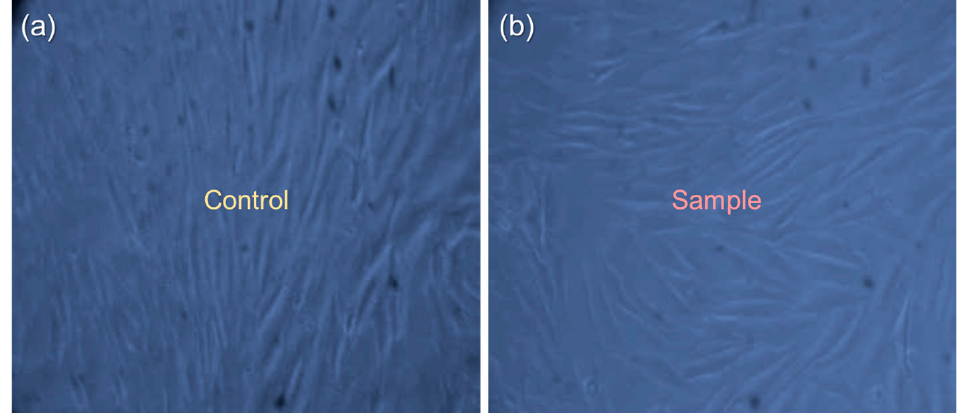
Figure 8. Optical microscopy images (magnification: × 20) of the live/dead cell assay measured through the Trypan blue staining method for the ( a ) control and ( b ) Eu,Y-nHAP/CS biocomposites seeded with the MG63 cell.